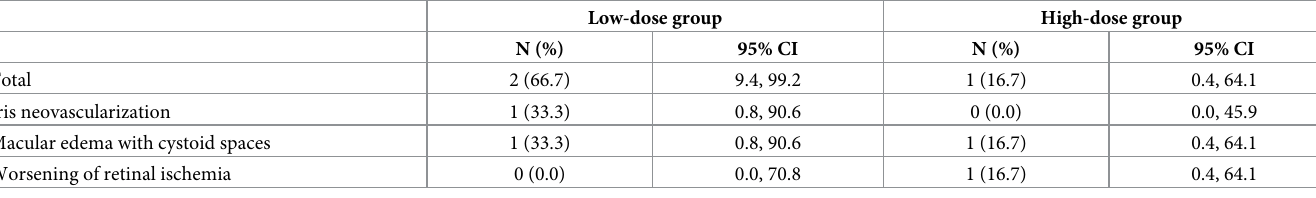
Table 3. Side effects that were undeniably associated with KUS121.